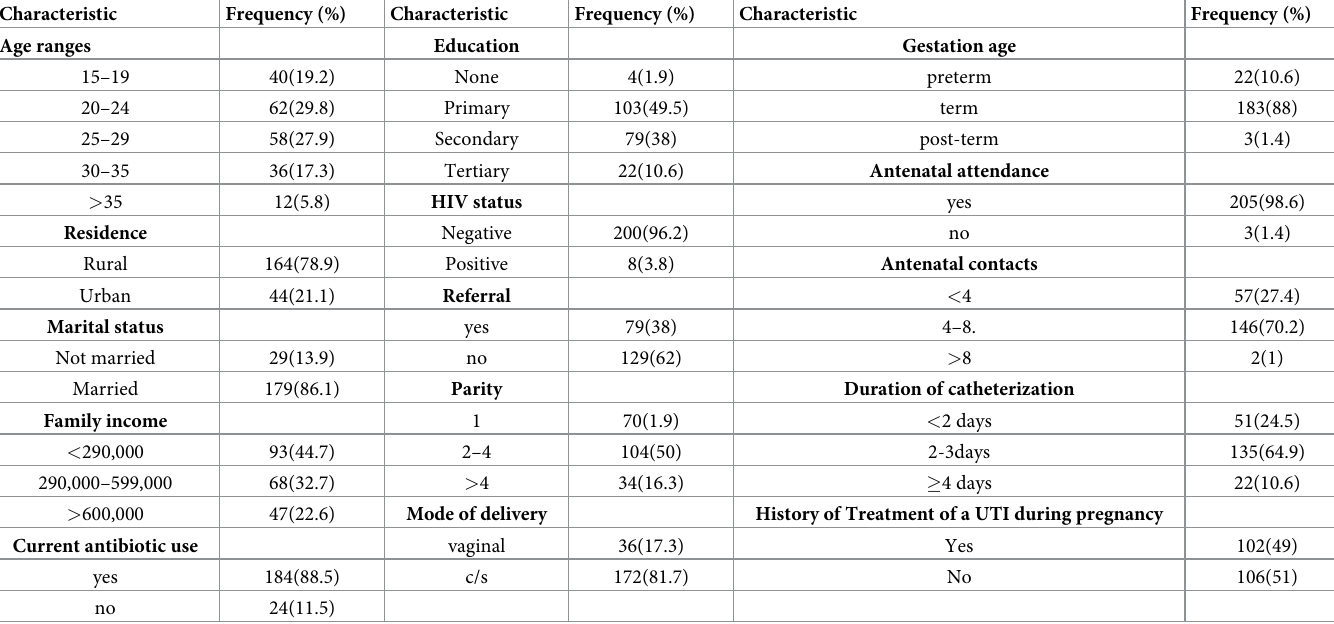
Table 1. Demographic characteristic of postpartum mothers with urinary catheters that were enrolled in the study at MRRH. Characteristic Frequency (%) Characteristic Frequency (%)